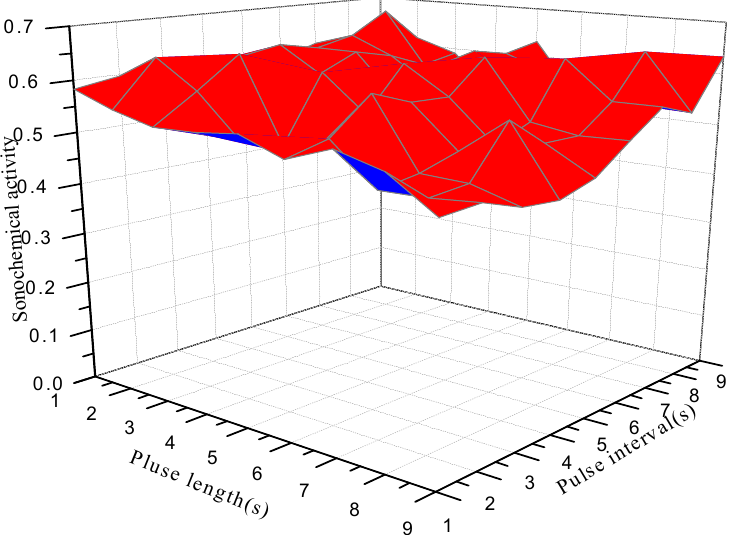
Figure 2. Influence of pulse length (1–9 s) and pulse interval (1–9 s) on the sonochemical